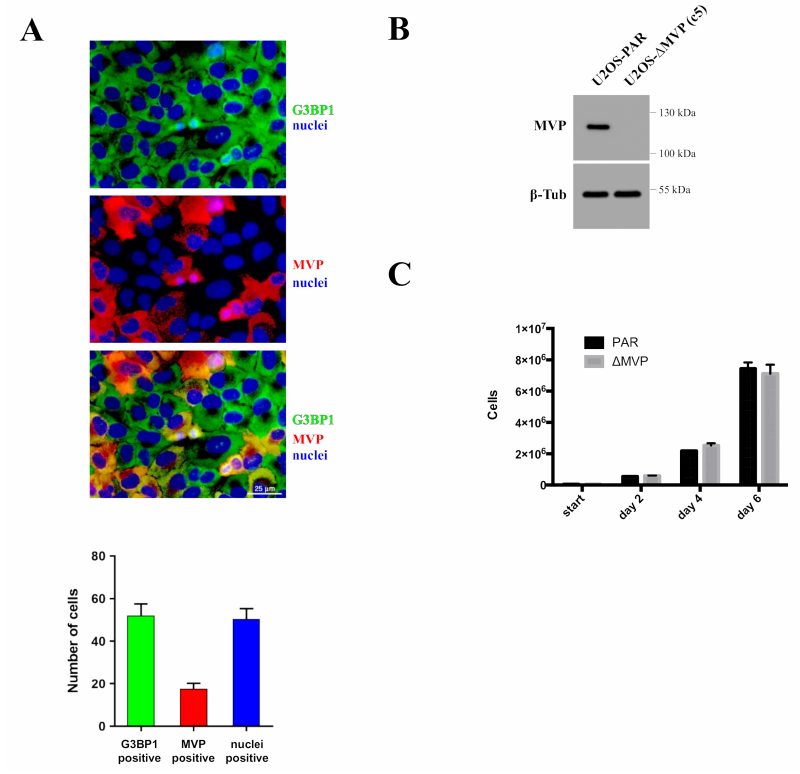
Figure 3. Generation of MVP-negative modified U2OS cells using the CRISPR-Cas9 method. ( A ) Parametric evaluation of the number of cells lacking MVP expression. The G3BP1 protein is expressed in the cytoplasm and was used as a marker for monitoring all cells (green). The MVP is marked red. Cell nuclei are highlighted in blue. The graph shows parametrically the number of total cells (G3BP1—green color, DAPI/nuclei—blue color, MVP—red color). ( B ) Analysis of MVP expression in parental cells (U2OS-PAR) and in modified MVP-negative cells—c5 clone (U2OS- ∆ MVP (c5)). ( C ) Cell proliferation analysis on parental (U2OS-PAR) and MVP-negative U2OS cells (U2OS- ∆ MVP